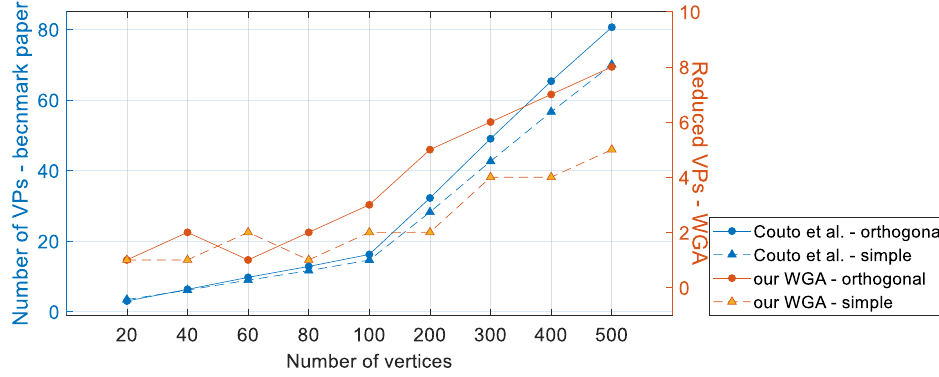
Figure 13. Reduced viewpoints of our WGA method to the benchmark paper method.